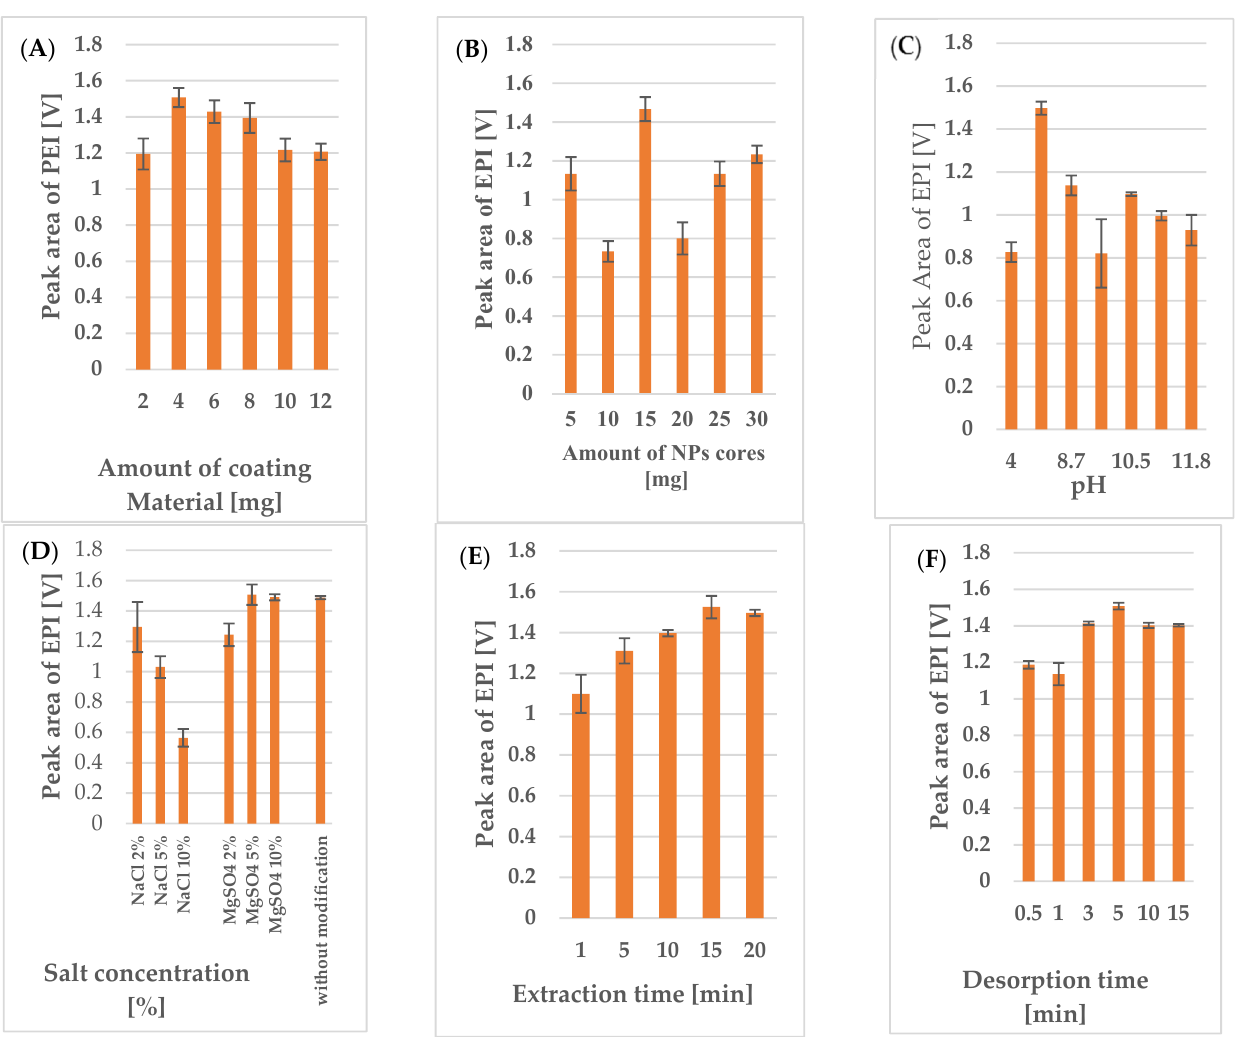
Figure 1. E ff ects of ( A ) the amount of coating material, ( B ) the amount of NP cores, ( C ) pH, ( D ) salting-out, ( E ) extraction time, and ( F ) desorption time on the peak area of EPI (0.5 µg/mL) obtained via LC-FL analysis.